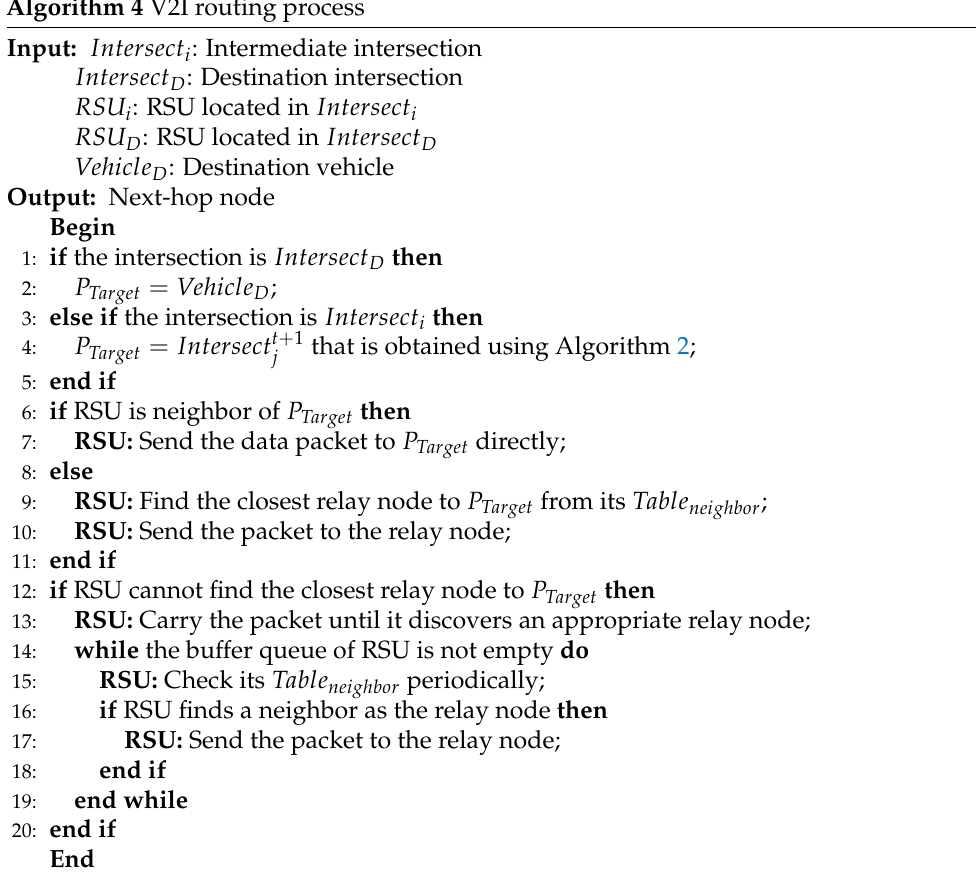
Algorithm 4 V2I routing